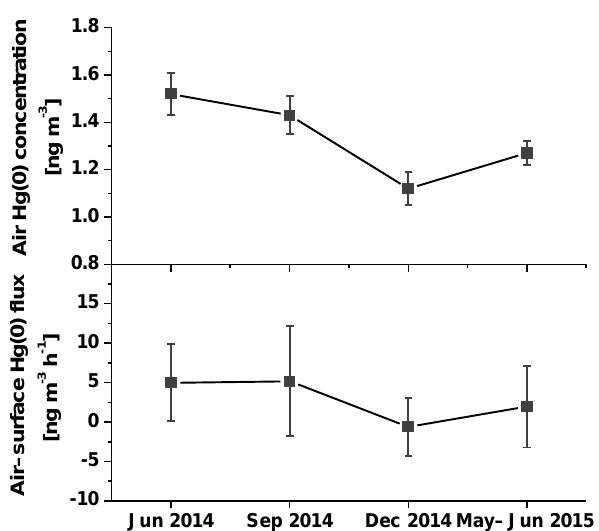
Figure 3. Seasonal variation in Hg(0) concentration in ambient air and air–surface Hg(0) flux during four campaigns at the Beiluhe station in the central QTP in